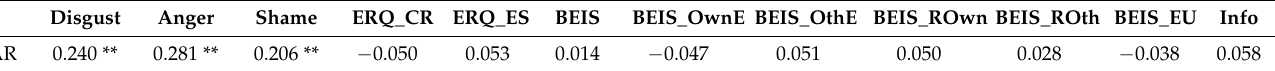
Table 3. Correlation coefficients (Pearson’s r) between the AR and negative emotions, ERQ, and BEIS ( n = 509)